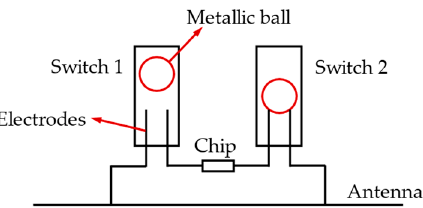
Figure 8. Schematic diagram of a vibration sensor tag with vibration-sensitive switches.